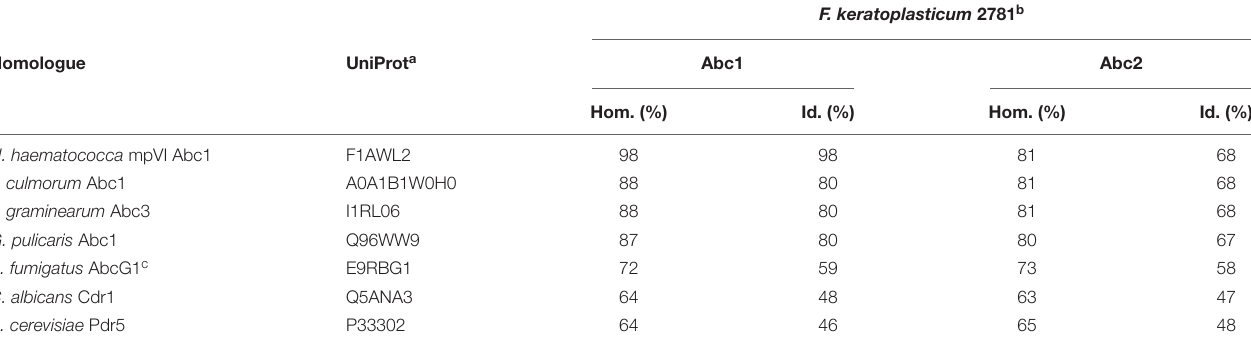
TABLE 5 | F. keratoplasticum Abc1 and Abc2 sequence similarities to the indicated Abc1 homologues of other fungi. F. keratoplasticum 2781 b Homologue UniProt a Abc1 Abc2 Hom. (%) Id. (%) Hom. (%) Id.